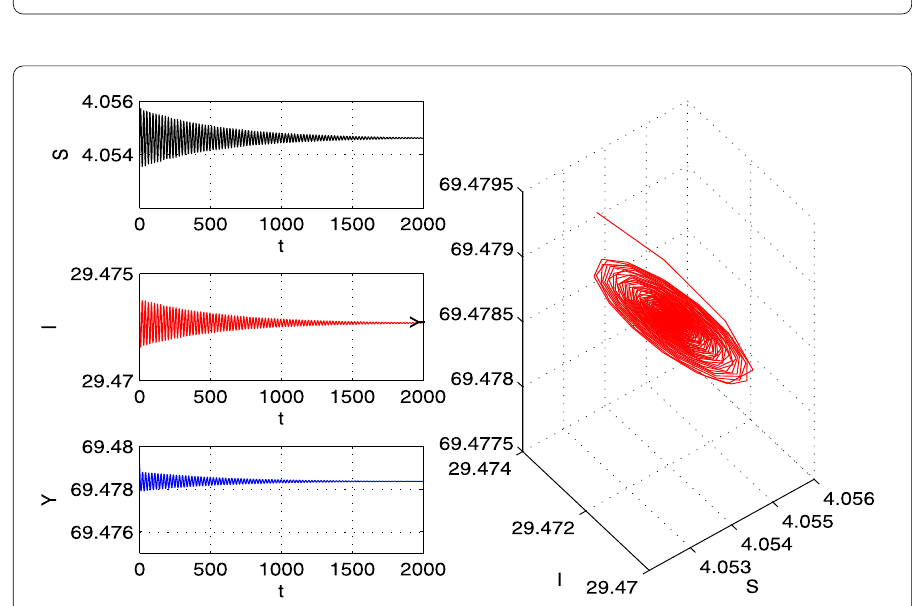
Figure 2 The trajectories of system (4.1) with τ 1 = 5.79 < τ 10 = 5.8744, τ 2 = 0. The positive equilibrium E is asymptotically stable. The initial value is